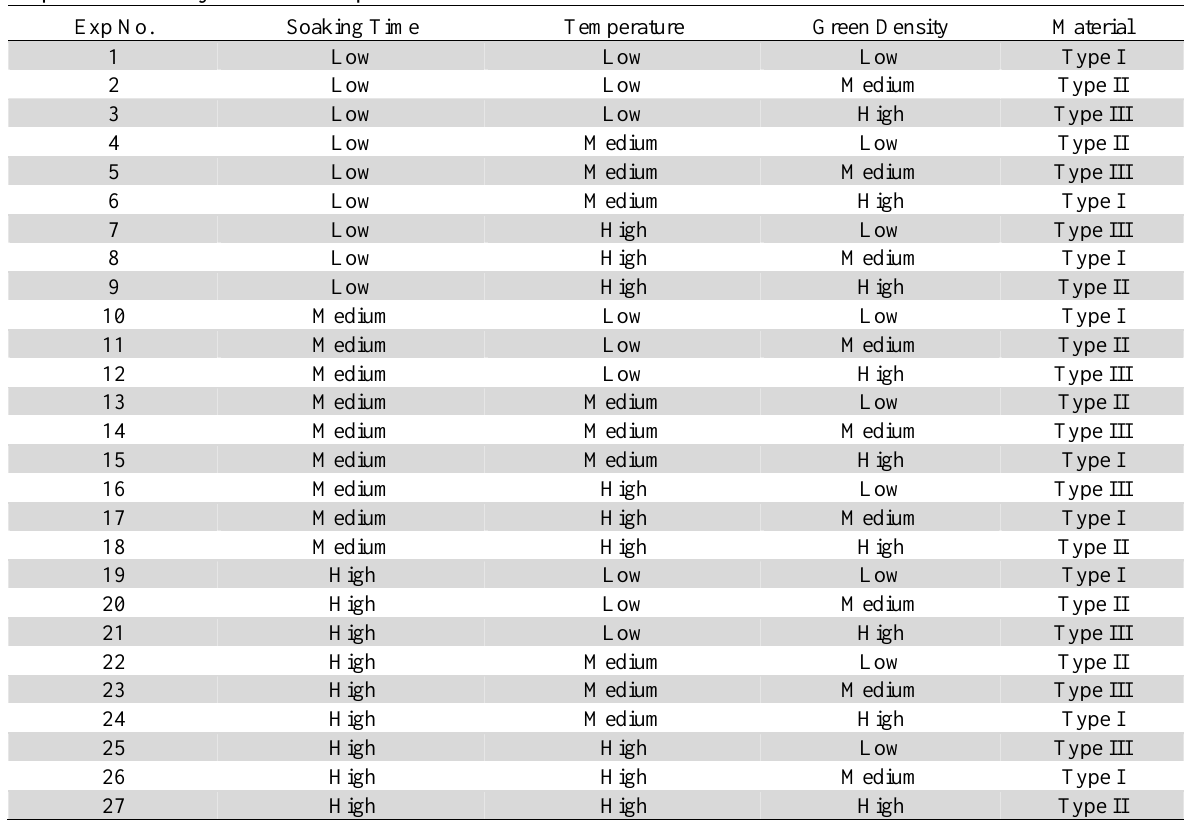
Experimental Layout with Response values Exp